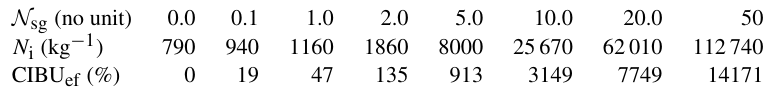
as a function of the number of fragments max